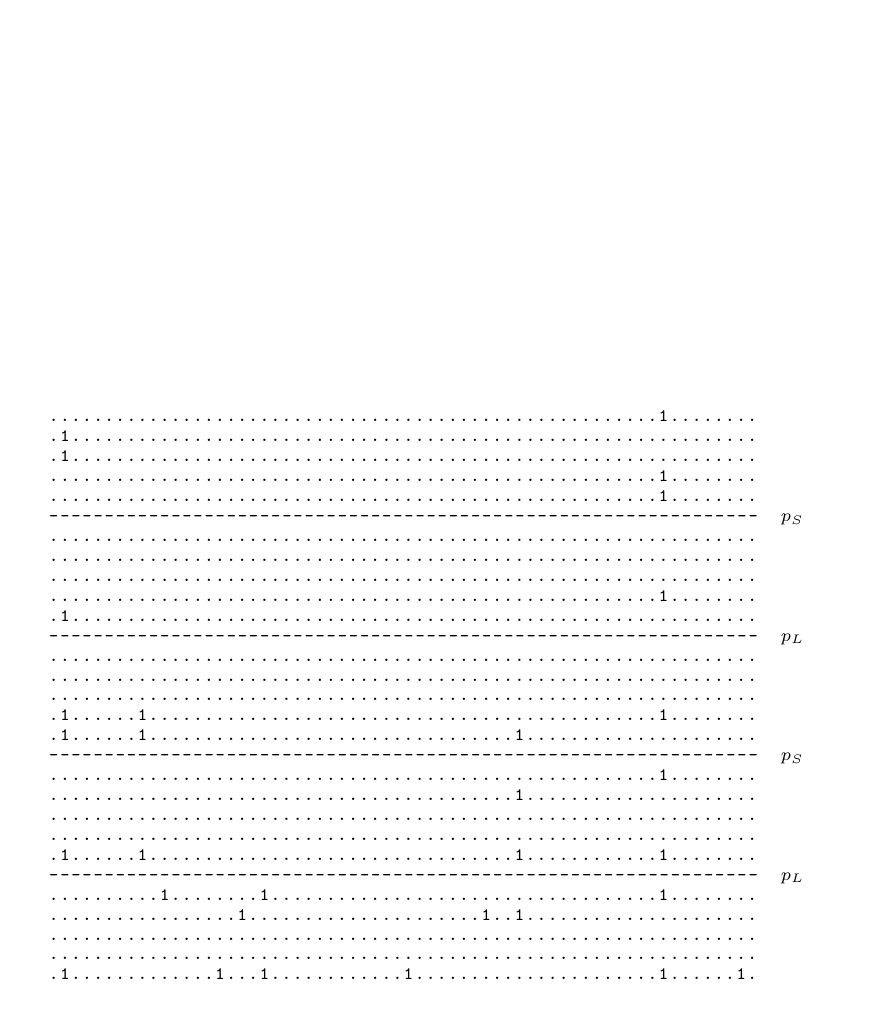
Figure 3: 3-round trail with 16 [2, 4, 10] active Sboxes and weight 43 [4, 12,